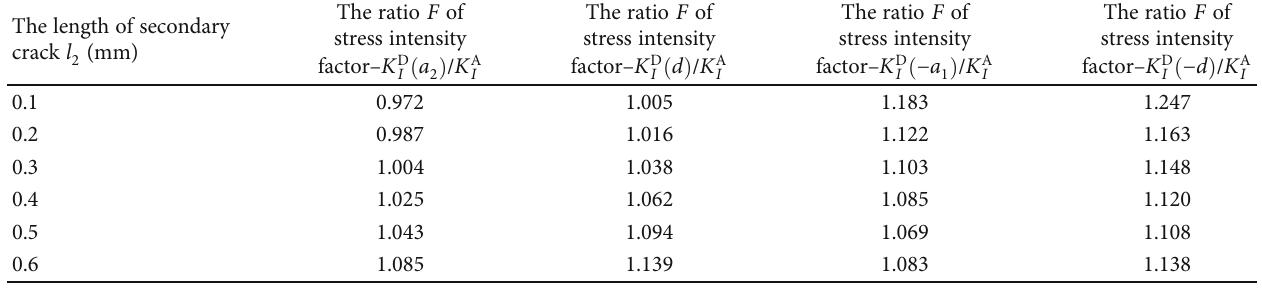
Table 3: Relationship between the ratio F of stress intensity factor and the length of secondary crack l The length of secondary